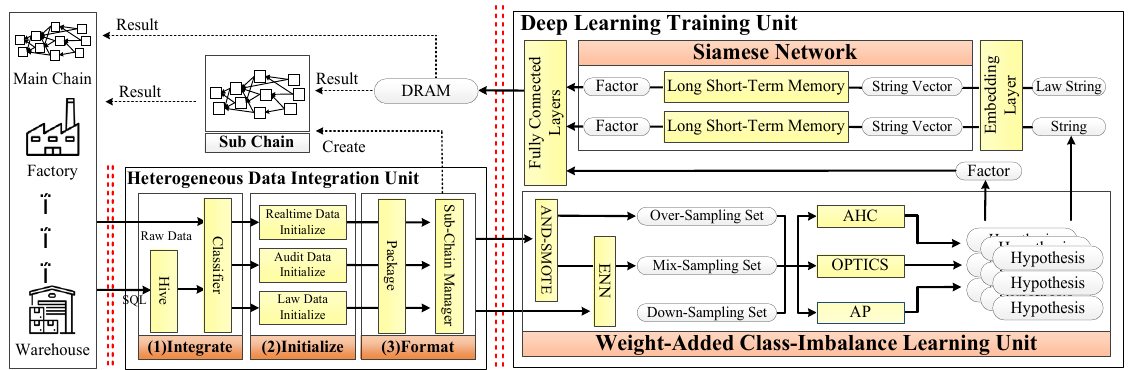
Figure 6. The working flow of the deep-learning-oriented food safety, risk, reasoning, and analysis model.